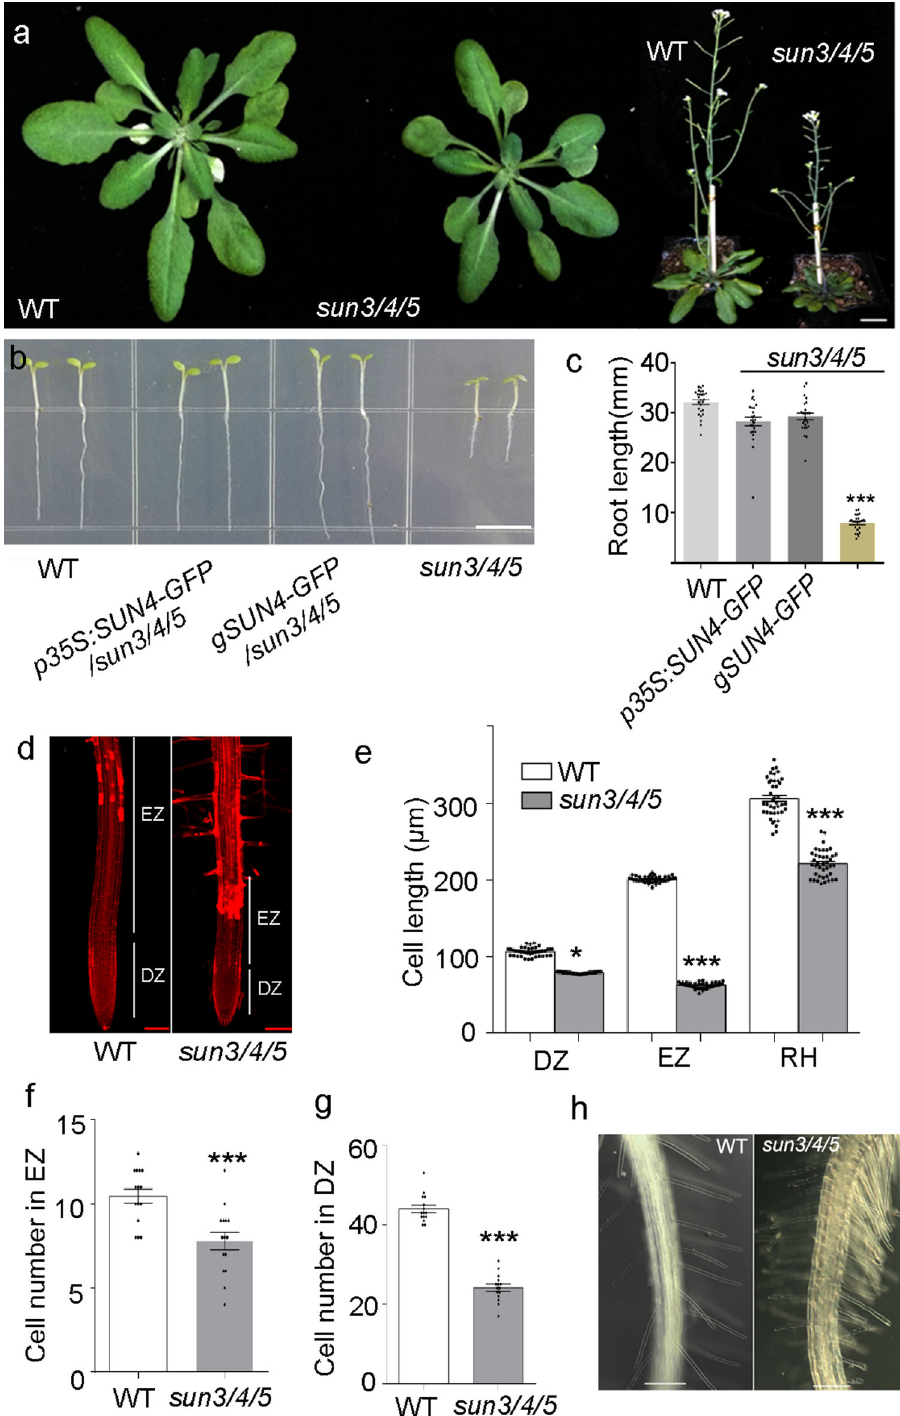
Fig. 3 Vegetative phenotype of sun3/4/5 . a sun3/4/5 plants are smaller and dwarf than the WT. Bar, 2 cm. b The shortened root of sun3/4/5 can be rescued by SUN4-GFP driven by the 35 S and SUN4 promoters, respectively. The seedlings were grown for 7 days after germination (DAG). Scale bar, 0.5 cm. c Statistics of root length of different genotypes. More than 300 seedlings from 6 independent plants of each transgenic line were measured at 7 DAG. The values represent means ± s.e.m., Two-tailed Student ’ s t -test, p* ** < 0.001. d Division and elongation zone of WT and sun3/4/5 roots at 7 DAG stained with propidium iodide. DZ, division zone; EZ, elongation zone. 3 independent biological experiments were independently repeated. Scale bar, 100 μ m. e Cell length in different zones of WT and sun3/4/5 roots at 7 DAG. RH, root hair. The values represent means ± s.e.m., Two-tailed Student ’ s t -test, p * < 0.05, p *** < 0.001. For DZ measurements, n = 40 and 37 separately. For EZ measurements, n = 38 and 40 separately. For RH measurements, n = 41 and 40 separately. f Statistics of cell numbers in the elongation zone. 15 seedlings of WT and sun3/4/5 were measured at 7 DAG. The values represent means ± s.e.m., Two-tailed Student ’ s t -test, p *** < 0.001. g Statistics in cell number in division zone. 15 seedlings of WT and sun3/4/5 were measured at 7 DAG. The values represent means ± s.e.m., Two-tailed Student ’ s t -test, p *** < 0.001. h Root hairs. 3 independent biological experiments were repeated. Bar, 100 μ m. NATURE COMMUNICATIONS| (2022) 13:2703 |https://doi.org/10.1038/s41467-022-30179-w|www.nature.com/naturecommunications